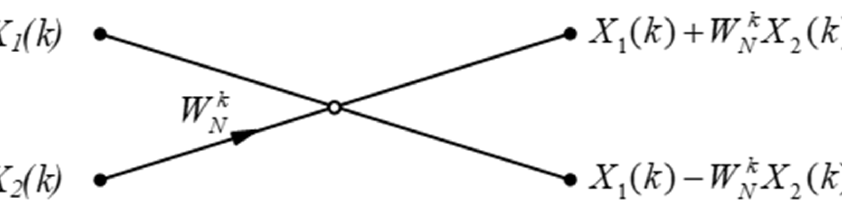
Figure 2. Calculation flow diagram of FFT.